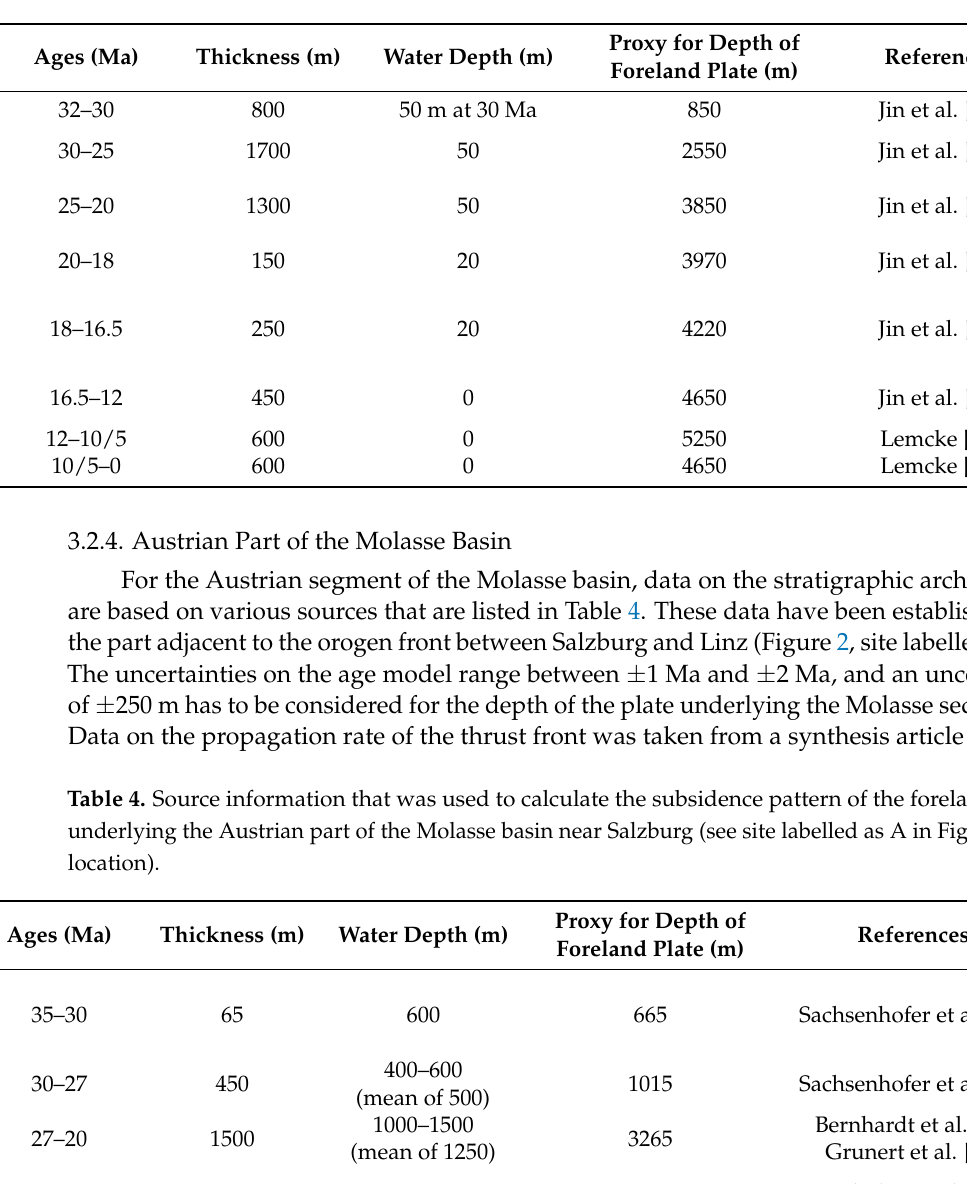
Table 3. Source information to infer the subsidence of the foreland plate underlying the German part of the Molasse basin (see site labelled as G in Figure 2). OSM = Upper Freshwater Molasse.